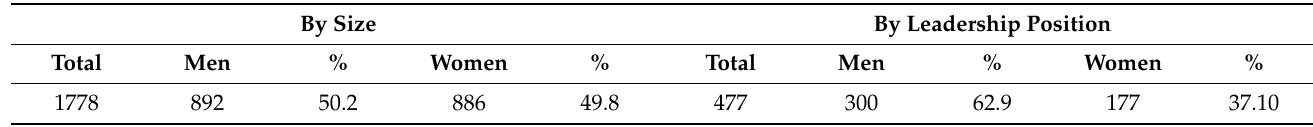
Table 3. Banco de Portugal HR by size and by leadership position.